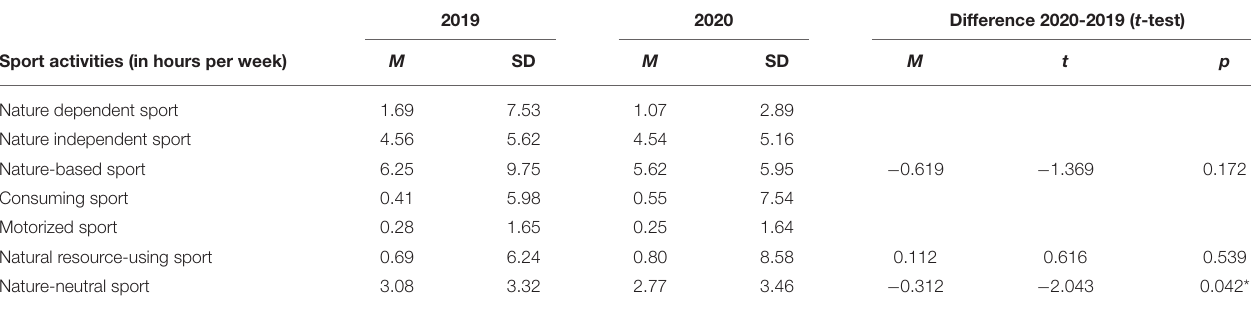
TABLE 4 | Sport activities in 2019 and 2020 ( n = 412).